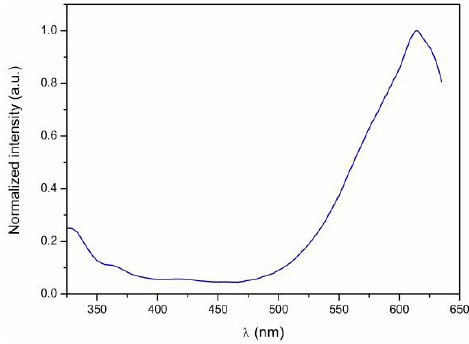
Figure 3. The normalized excitation spectrum of Ox170 perchlorate doped PMMA.